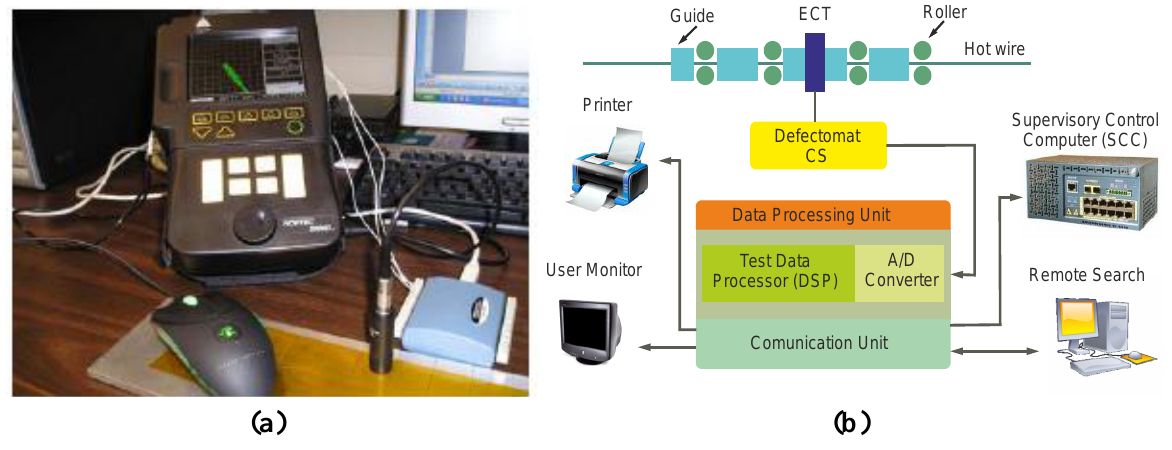
Figure 29. (a) Portable eddy current testing instrument [78]. (b) Block diagram of the overall system for hot wire testing (adapted from